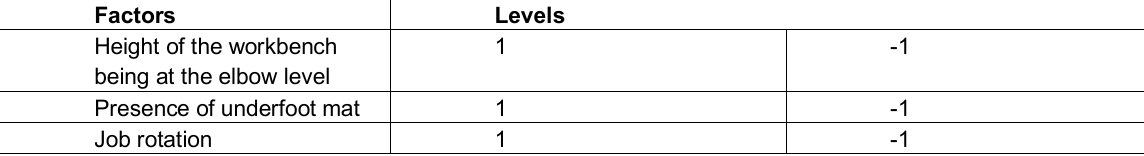
Table 1 : Factors and Their Levels